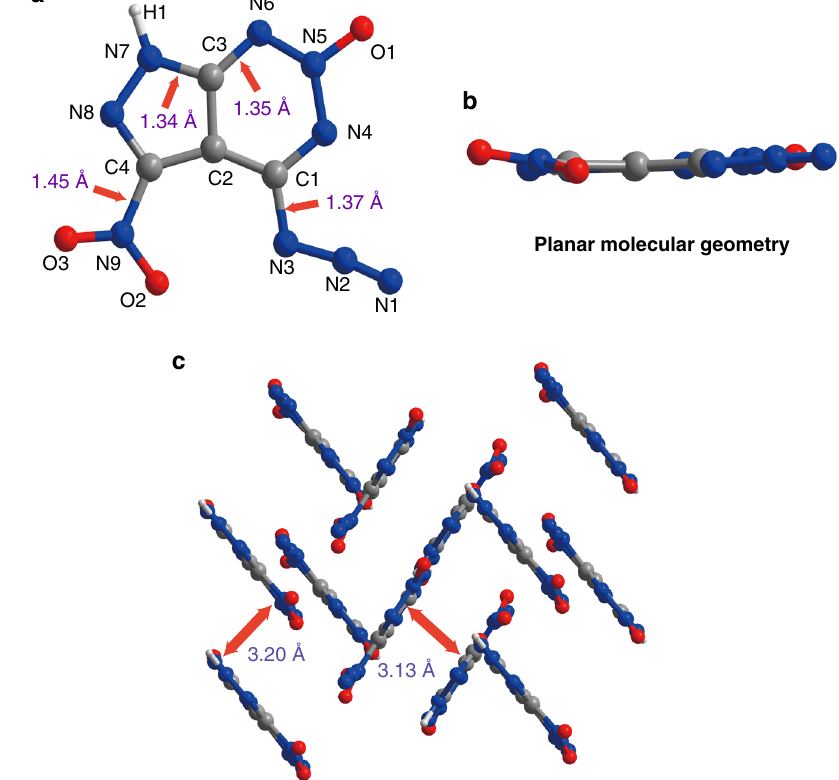
Fig. 2 Molecular structure and crystal packing of ICM-103. a The molecular structure of ICM-103. b The planar molecular geometry of ICM-103. c The crystal stacking structure of